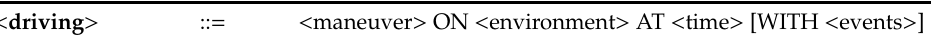
Table A1. The driving components.